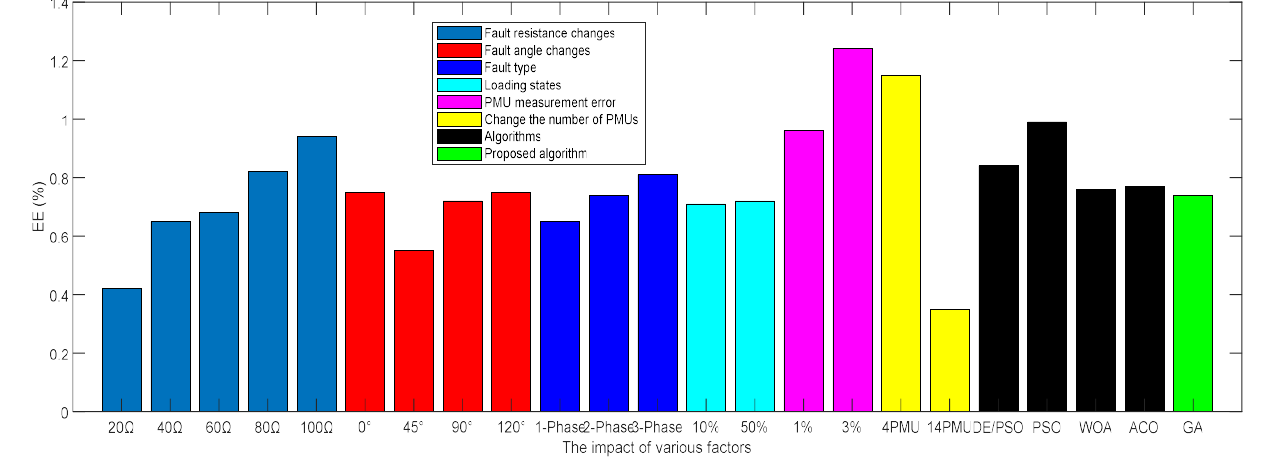
26 of 31 Table 6. Performance of different algorithms in solving a fault location problem. Parameter Genetic Algo- rithm Algorithms Hybrid DE/PSO [55]